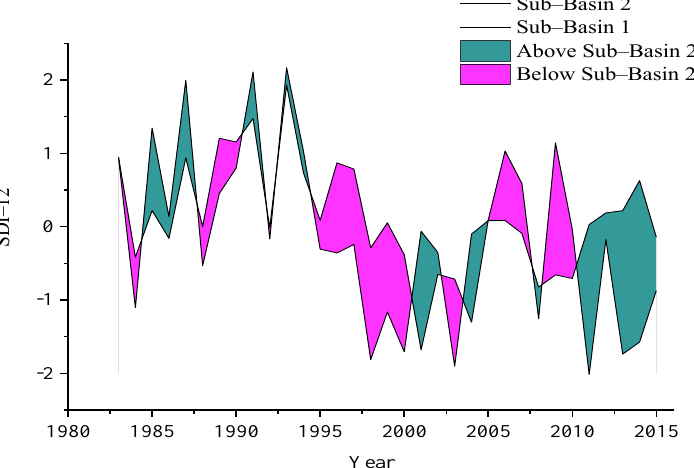
Figure 5. Difference in Hydrological drought (SDI–12) severity at both sub-basins representing the spatial variations across the Soan river basin.